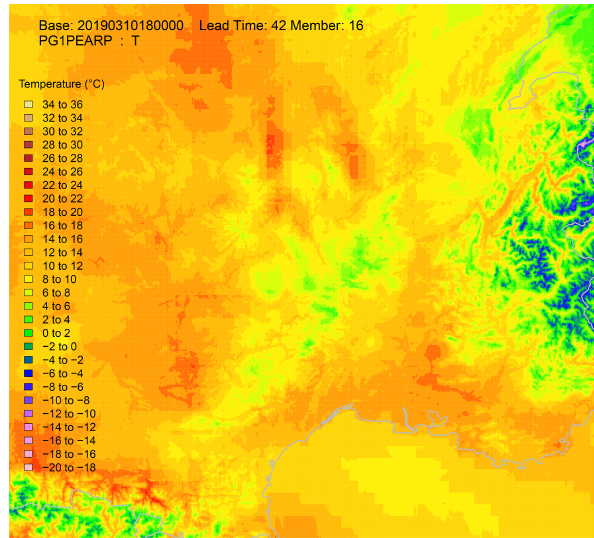
Figure 10. Resulting field over the south-east of